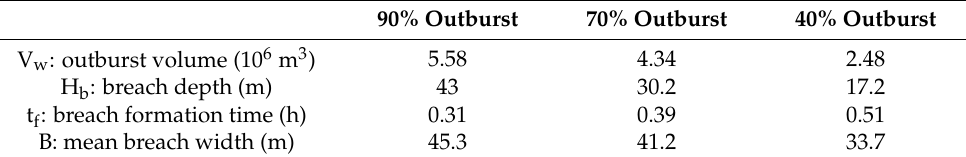
Table 1. Anticipated outburst volumes, corresponding breach depths and dam breach parameters calculated by the equations of Fröhlich